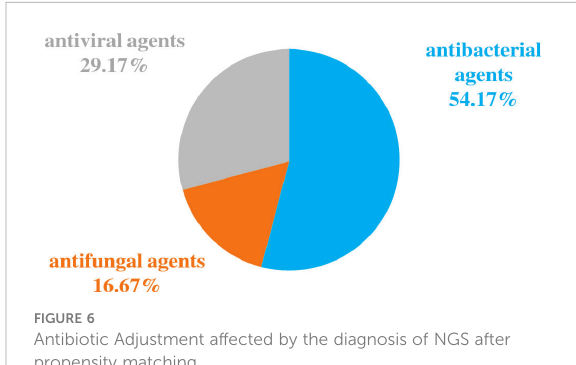
FIGURE 6 Antibiotic Adjustment affected by the diagnosis of NGS after propensity matching.